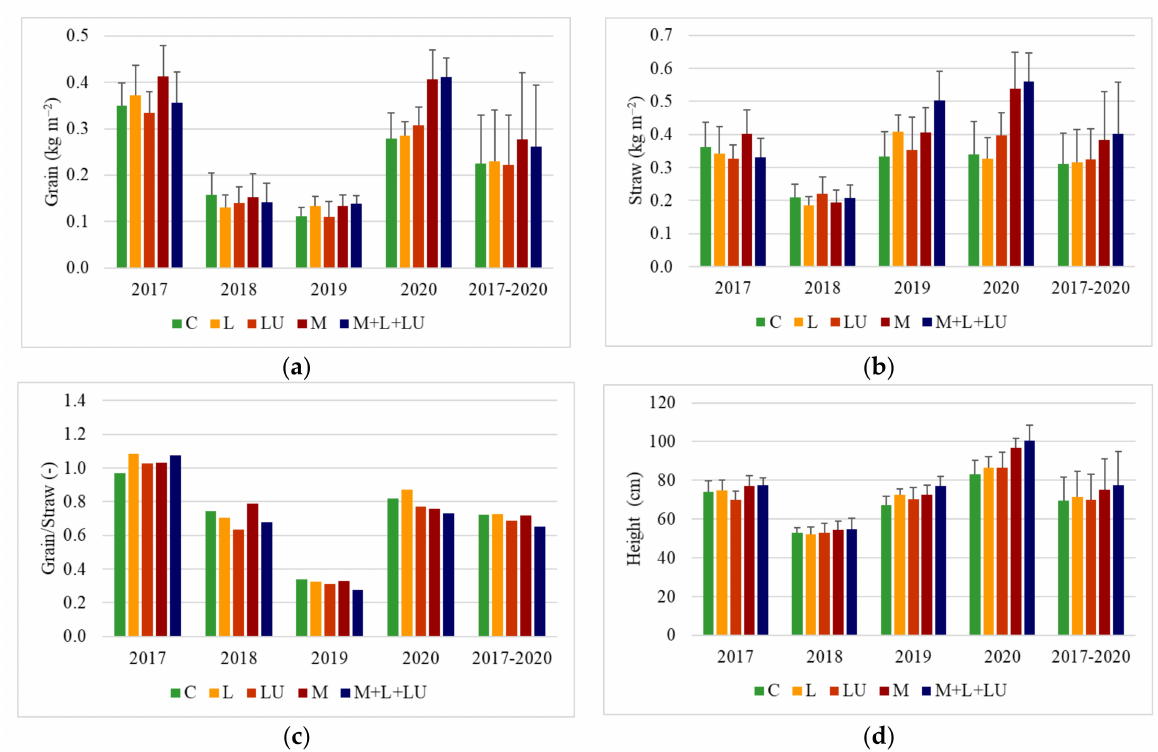
Figure 2. Mean values of the grain yield ( a ), straw yield ( b ), grain to straw yield ratio ( c ), plant height ( d ), and in response to soil-improving cropping systems. C—control, L—liming, LU—leguminous catch crops, M—farmyard manure and M + L + LU—farmyard manure + liming + leguminous catch crops. The vertical bars indicate the standard deviations (n =